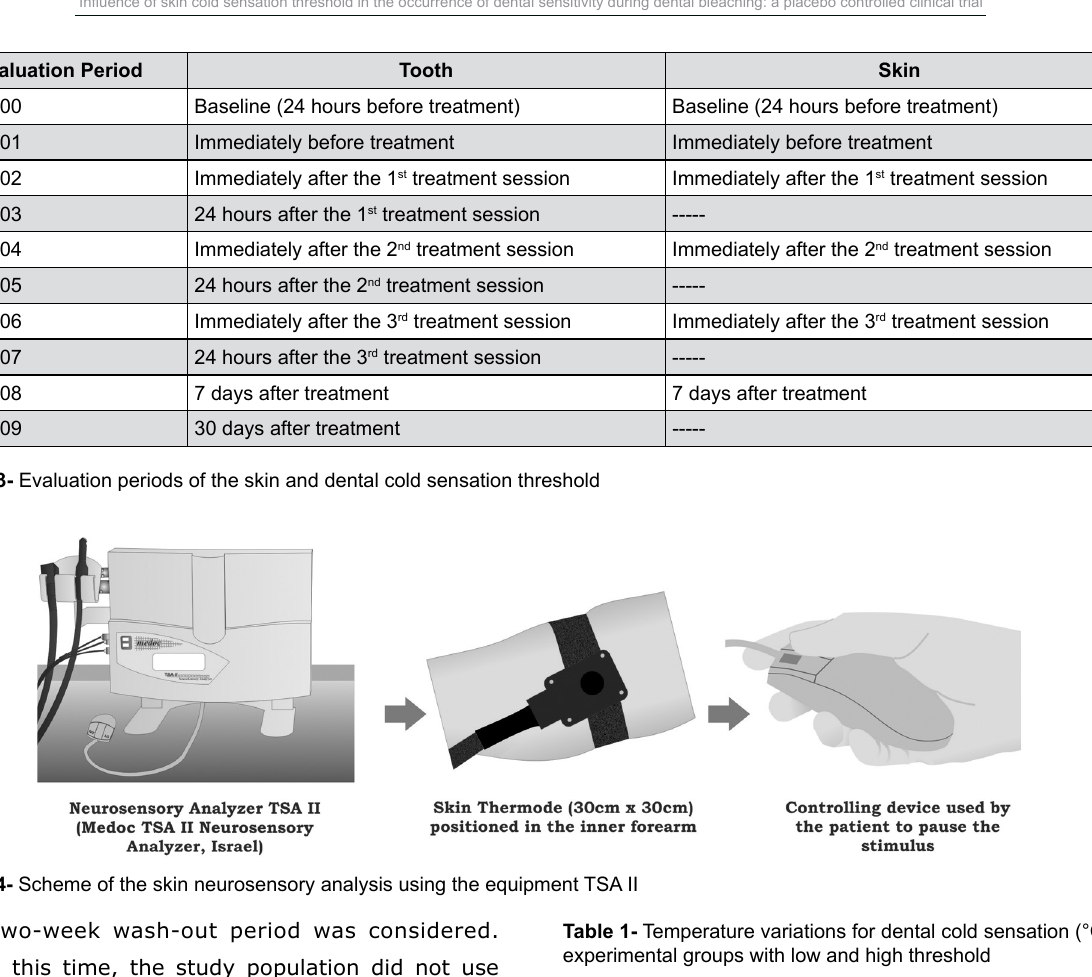
Table 1- Temperature variations for dental cold sensation (°C) of experimental groups with low and high threshold Evaluation Periods